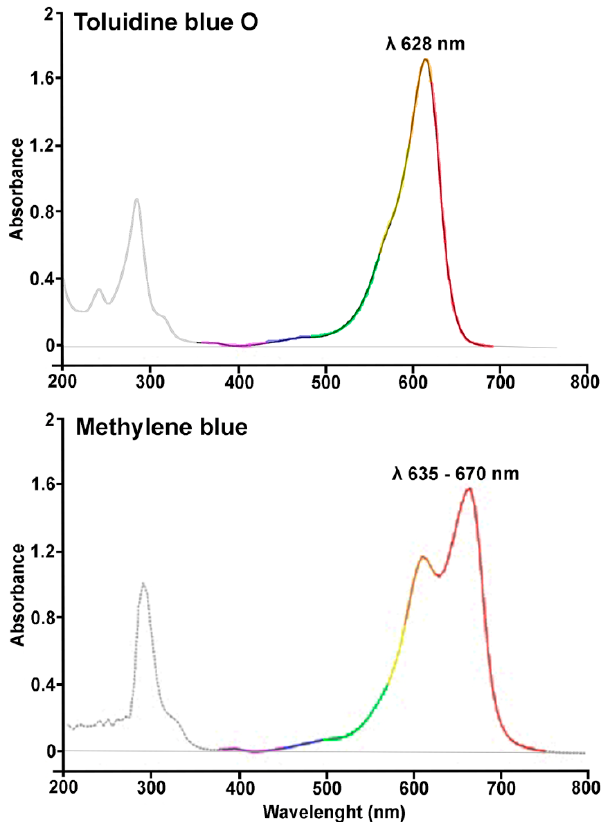
Figure 2. Absorption spectra of toluidine blue O and methylene blue, two phenotiazinic dyes most commonly used as photosensitizers in photodynamic therapy (PDT). Optimal photochemical reactive oxygen species (ROS) generation and anti-microbial e ff ects are achieved with light wavelengths coincident with the absorption peaks.